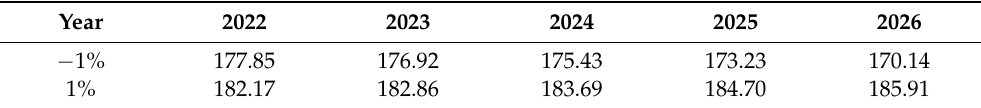
Table 17. Prediction result of water requirement with different growth rates of AVSI in Hebei Province.